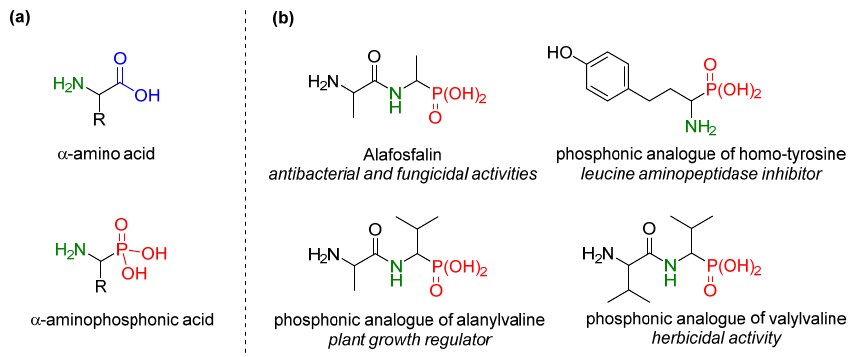
Figure 1. ( a ) Structure of α -amino acid and α -aminophosphonic acid; ( b ) Selected examples of biologically active phosphonic analogues of α -amino acids and their derivatives.